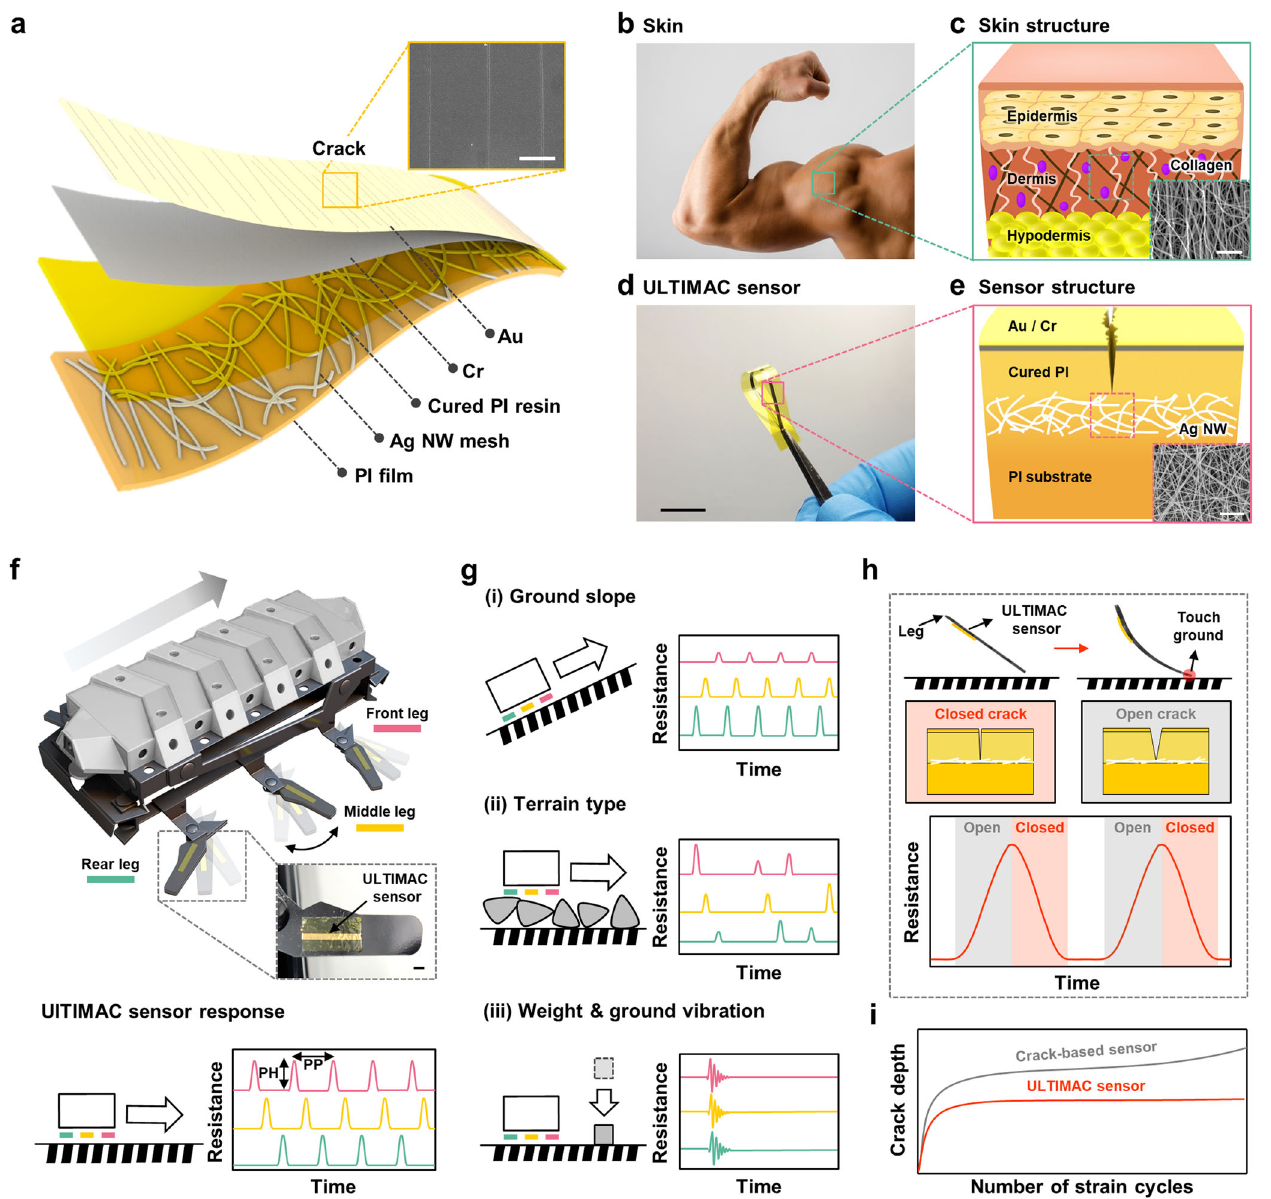
Fig. 1 Overview of ULTIMAC sensor and its robotic application in terrain sensing. a Schematic layup of the ULTIMAC sensor used in this work. The inset shows the SEM image of nano metal cracks (Scale bar: 2 μ m). b Image of skin that its remarkable toughness with high fl exibility. c Skin consists of three layers: the epidermis, the dermis, and the hypodermis. The collagen fi bers that make up most of the dermis are curvy and disordered in a non-stressed state but becomes rearranged toward tensile load direction under a stressed state. The inset shows the SEM image of arti fi cial skin collagen (Scale bar: 10 μ m). d Image of a tough ULTIMAC sensor. The lateral dimensions are 5 × 30 mm on 10 μ m thick substrate. e The ULTIMC sensor consists of four layers: a metalized layer, a cured PI layer, an Ag NW mesh layer, and a PI substrate. The embedded Ag NW layer mitigates crack growth. The inset shows the SEM image of an Ag NW mesh (Scale bar: 1 μ m). f Schematic illustration of a robotic application sensing terrain information by mounting an ULTIMAC sensors on robot feet, Inset: Photograph of an ULTIMAC sensor mounted on a robot foot (Scale bar: 1 mm). g Schematic illustration of terrain information derived from bending deformation data of robot feet. h The attached sensor to the compliant robot foot for detecting bending strain. i Schematic illustration of crack propagation with and without the Ag NW cycles as the crack deepened, before decreasing to 3000 due to at a 0.5% strain. At the beginning of the test, the gauge factors incomplete recovery from the stress accumulated at the crack (GF) determined by de fi nition (( Δ R/ R 0 )/ ε ) of the sensors was 2000 tip 29,50 . In contrast, the crack-based sensor with the Ag NW layer (with the Ag NW layer) and 3600 (without the Ag NW layer), had an almost constant GF (at 2000) and waveform from the start respectively, where Δ R is the change in electrical resistance, R 0 is to the end of the test, implying that crack propagation was the initial electrical resistance. Without the Ag NW layer, the crack successfully mitigated in this sensor (Supplementary Fig. 4). When grows more in-depth, so the crack-based sensor without an Ag tested during 10,000,000 cycles at high speed (100 Hz) at a 0.1% NW layer is more sensitive. The GF in the sensor without the Ag strain, this sensor continued to maintain similar levels of sensitivity NW layer increased gradually from 3600 to 4000 over 100,000